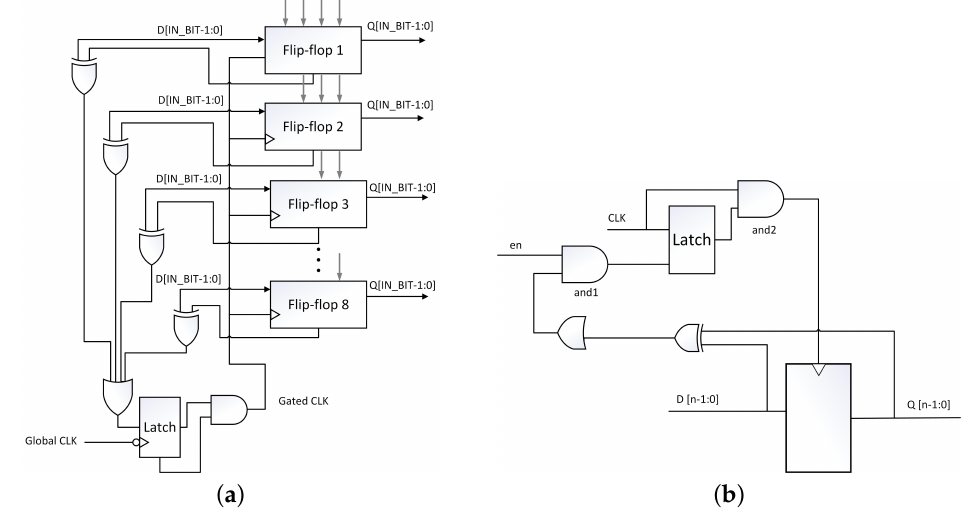
Figure 5. ( a ) Bus-specific clock gating (BSCG); ( b ) enhanced clock gating